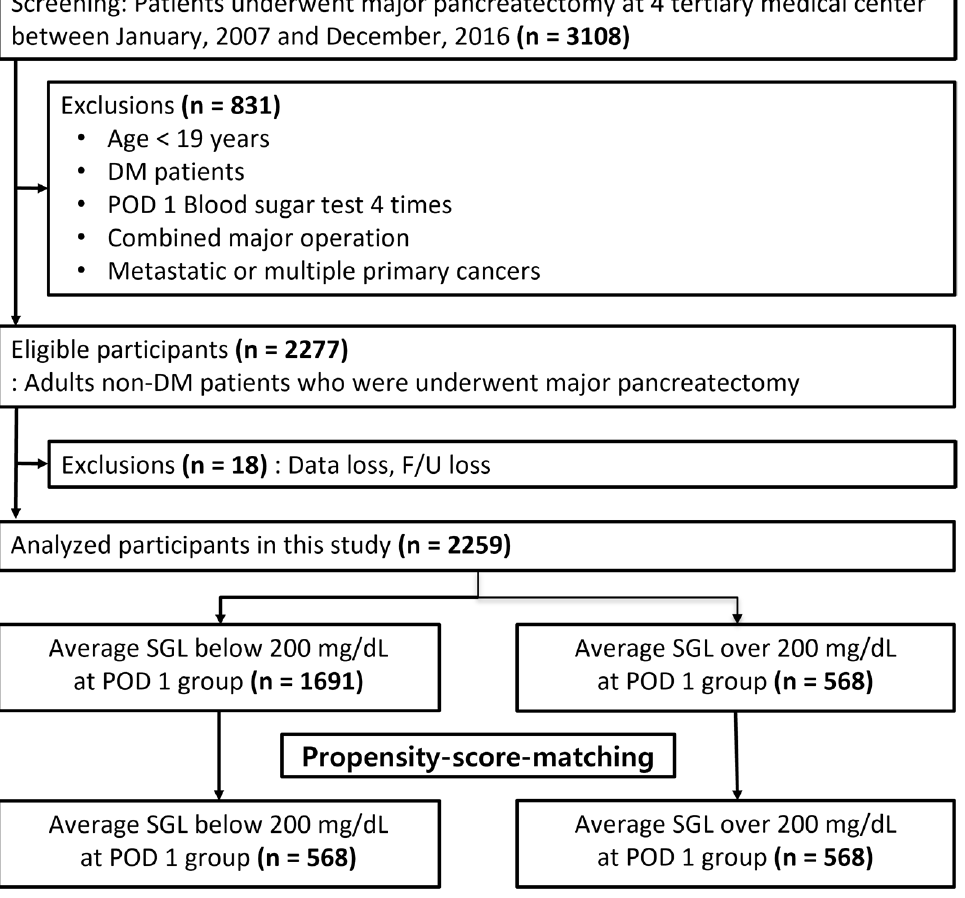
Figure 1. Flow diagram of patient selection.